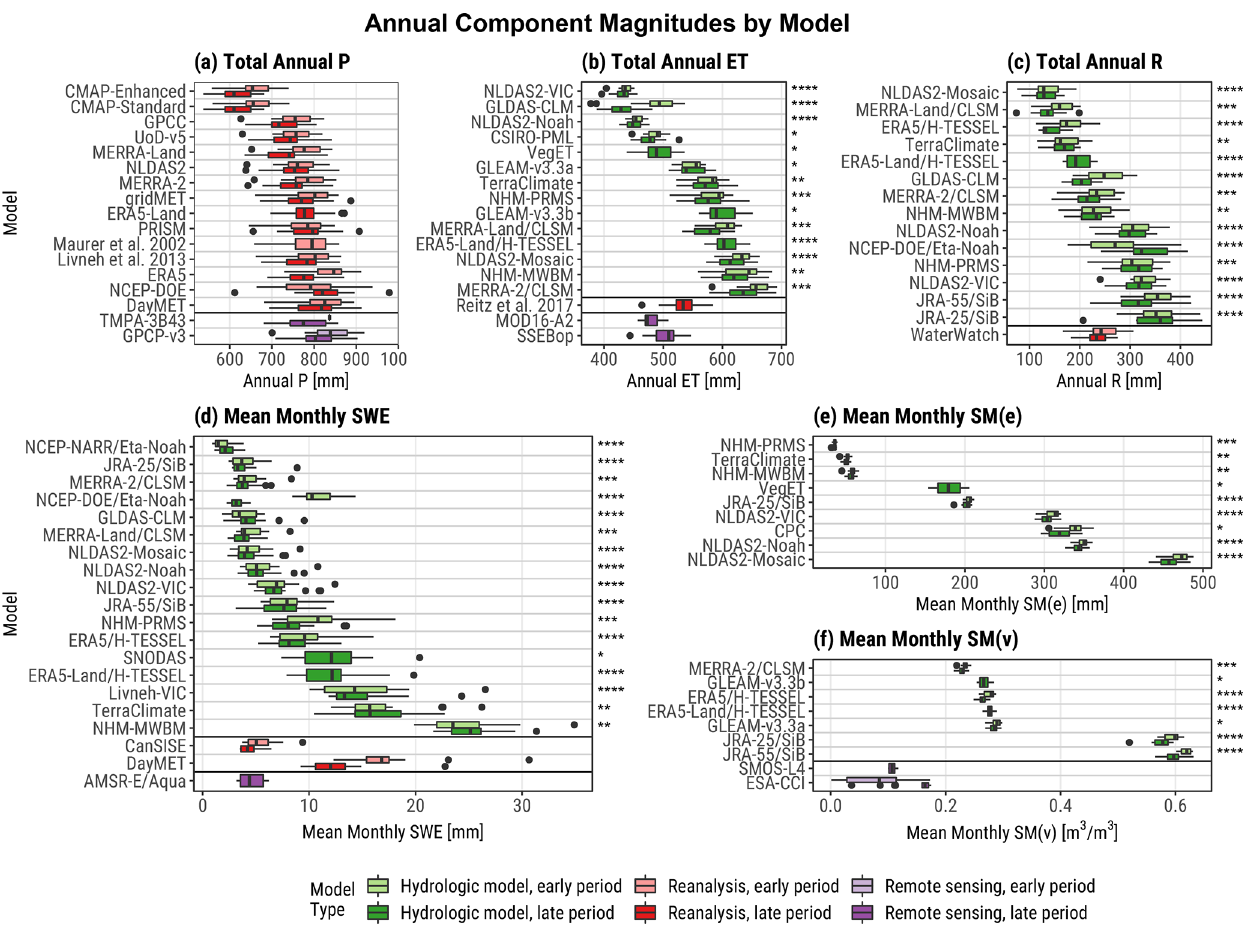
Figure 3. Box plots of annual water year magnitudes of all study model estimates averaged over the CONUS extent for hydrologic com- ponents (a) precipitation ( P ), (b) evapotranspiration (ET), (c) runoff ( R ), (d) snow water equivalent (SWE), (e) soil moisture in units of equivalent water depth (SM( e )), and (f) soil moisture in units of volumetric water content (SM( v )). Data set magnitudes are subdivided into two periods, i.e., 1985–1999 (top) and 2000–2014 (bottom), for each model. Flux component estimates ( P , ET, and R ) are summed from monthly values to calculate annual water year rates. Storage component estimates (SWE, SM( e ), and SM( v )) are averaged from monthly values to calculate annual water year average storage values. Box lower limits, midlines, and upper limits represent the 25th, 50th (median), and 75th percentiles, respectively, of the associated data. Whiskers represent 1.5 times the interquartile range. Box color denotes data set categories of hydrologic model, reanalysis, or remote sensing derived. Asterisks are used to identify the following hydrologic models types: land surface models ( ∗∗∗∗ ), catchment models ( ∗∗∗ ), water balance models ( ∗∗ ), and miscellaneous ( ∗